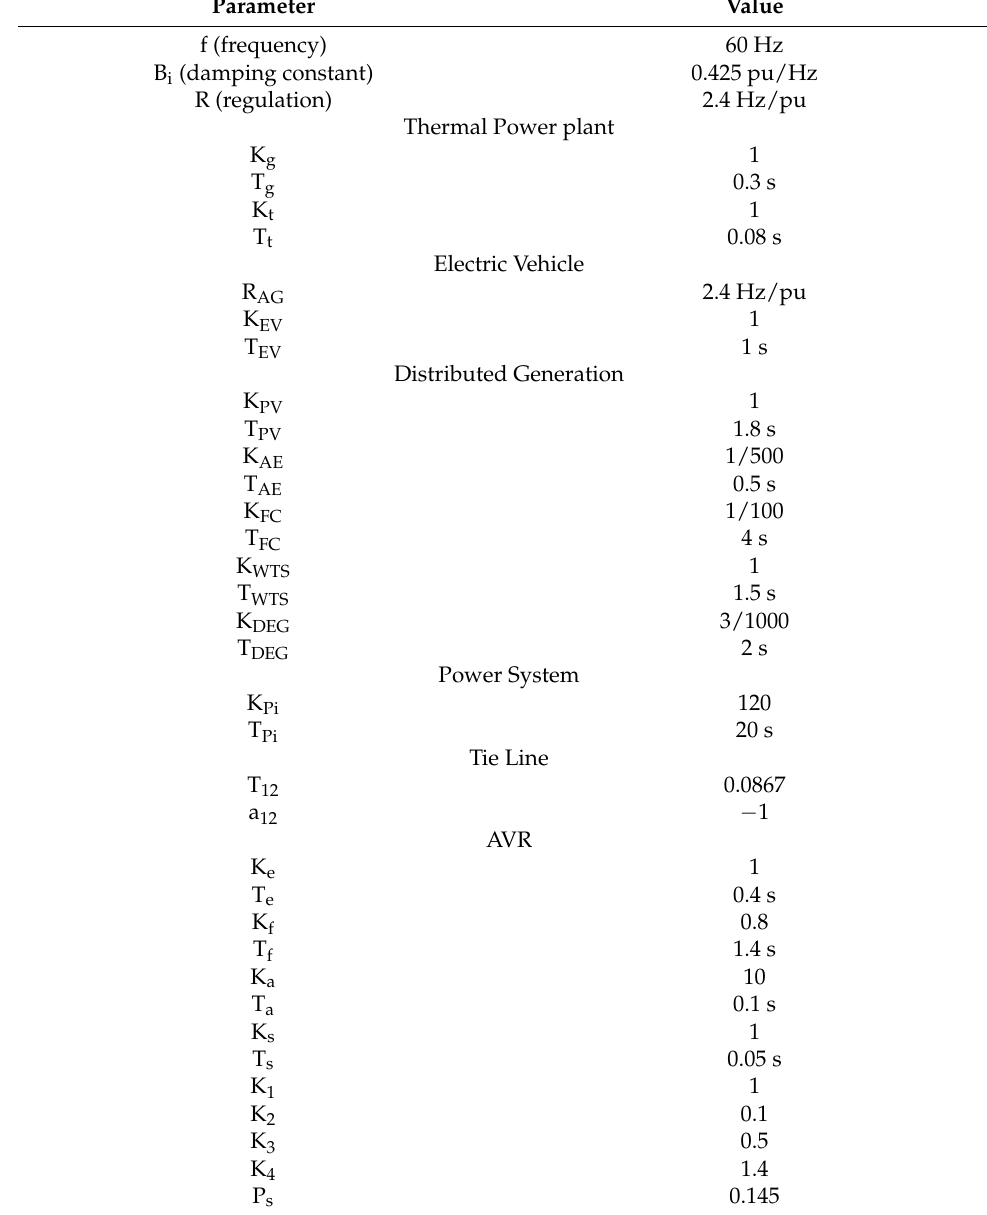
Table 1. Nominal system parameters used for